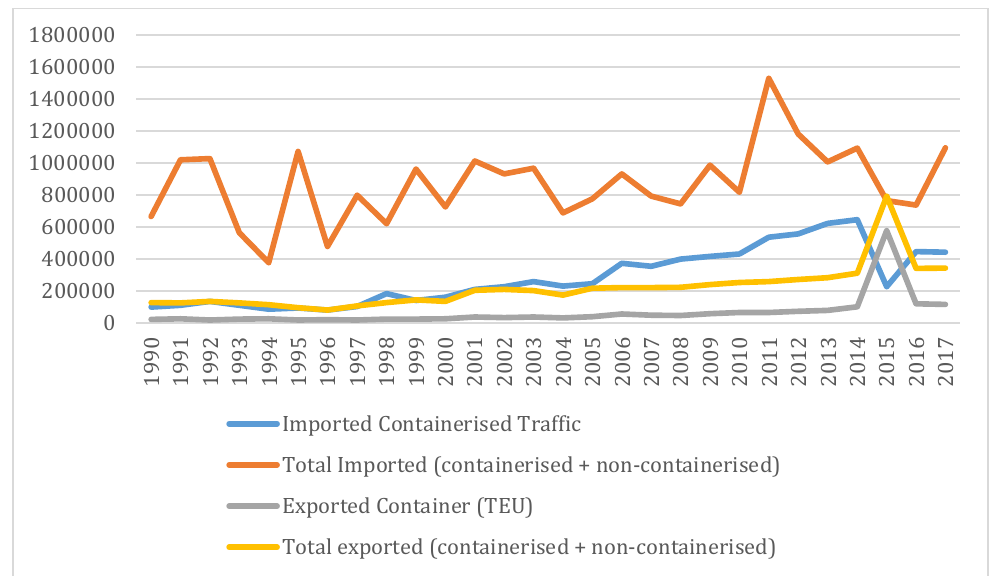
Figure 1: Relationship between total throughput and imported